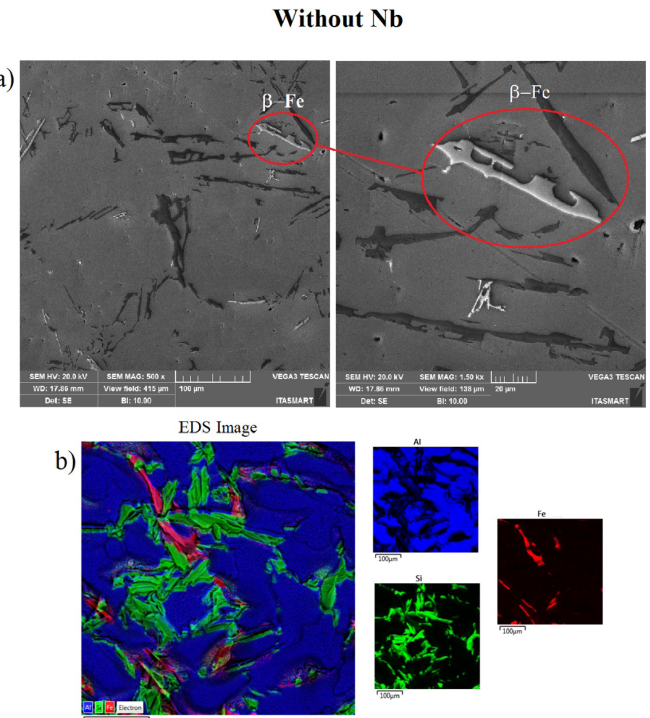
Figure 9. MEV: SEM-EDS maps highlighting typical β-Fe precipitates present in the alloys containing Al12Si1Fe without Nb+B inoculation. a) β-Fe highlighting showing image SEM with 500X and 1500X ampliation. b) Al, Si phase, and precipitates of the β-Fe are highlighted in blue, green, and